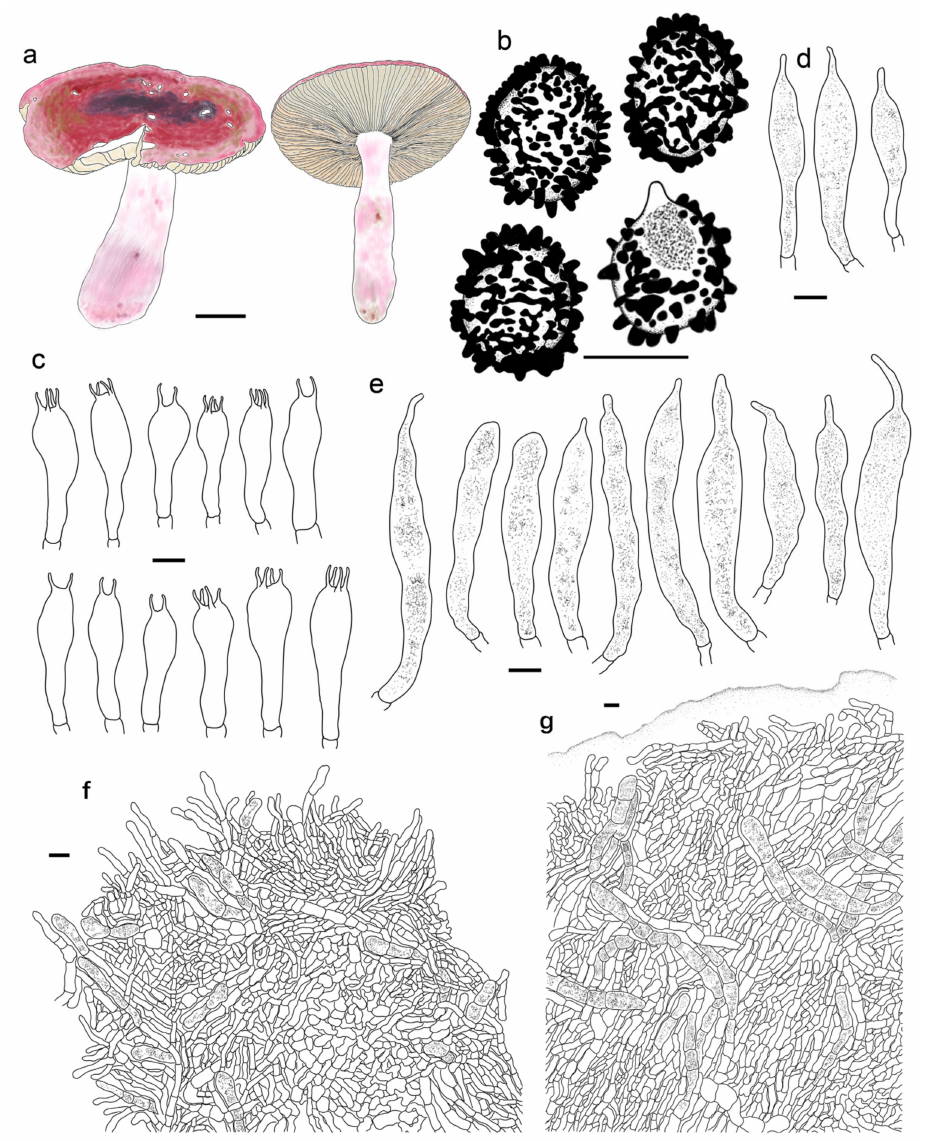
Figure 13. Russula rufa . (HMAS277048, Holotype). ( a ) Basidiomata . ( b ) Basidiospores . ( c ) Basidia . ( d ) Cheilocystidia . ( e ) Pleurocystidia . ( f ) Suprapellis and partial subpellis in pileus centre. ( g ) Suprapellis partial subpellis and in pileus margin. Bars: ( a ) = 10 mm, ( b ) = 5 µ m, ( c – g ) = 10 µ m. Description: Basidiomata small to medium sized. Pileus 34–56 mm in diam.; first pulvinate, hemispheric to convex, turning plano-convex to planate when mature; often shallowly depressed at centre, even infundibulum; mainly reddish tinged, sometimes intermixed with brownish, greenish and purplish tinges; Daphne Red (XXXVIII69 (cid:48)(cid:48) b), Eupatorium Purple (XXXVIII67 (cid:48)(cid:48) ) to Tourmaline Pink (XXXVIII67 (cid:48)(cid:48) b), rarely Livid Brown (XXXIX1 (cid:48)(cid:48)(cid:48) ), Purplish Vinaceous (XXXIX1 (cid:48)(cid:48)(cid:48) b) and Deep Brownish Vinaceous (XXXIX5 (cid:48)(cid:48)(cid:48) ), becoming Dragon’s Blood Red (XIII5 (cid:48) i), Dark Olive Buff (XL21 (cid:48)(cid:48)(cid:48) ), and Vinaceous Tawny (XXVIII11 (cid:48)(cid:48) ) when mature; sometimes turning Ecru-Olive (XXX21 (cid:48)(cid:48) i), Light Yellowish Olive (XXX23 (cid:48)(cid:48) i) to Olive-Ocher (XXX21 (cid:48)(cid:48) ); dull, slightly glutinous when wet. margin acute to subacute, initially incurved, then flat, wavy and uplifted at last, infrequently cracked, indistinctly striated 1/6–1/4 from the edge inwards, peeling 1/6–1/4 of the radius